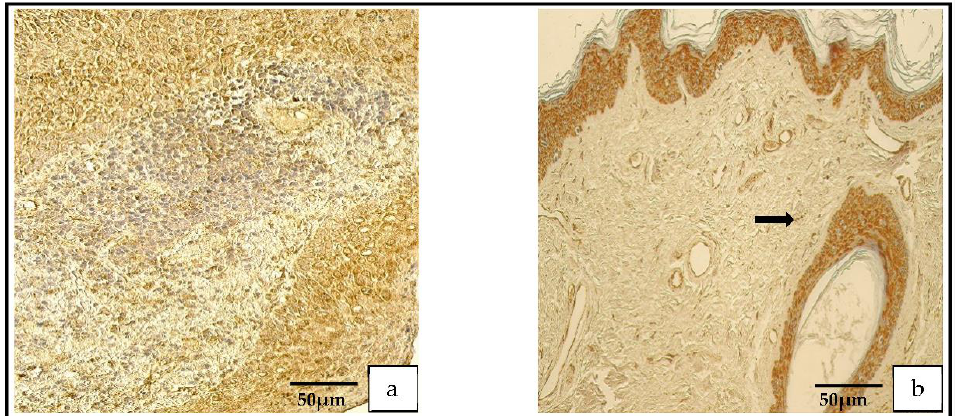
Figure 7. ( a – d ) Immunohistochemical micrographs. ( a ) Cholesteatoma . Moderate HβD– 2-positive cells in matrix and perimatrix, HβD– 2 IHC. ( b ) Skin . Few HβD– 2-positive cells in the epithelium